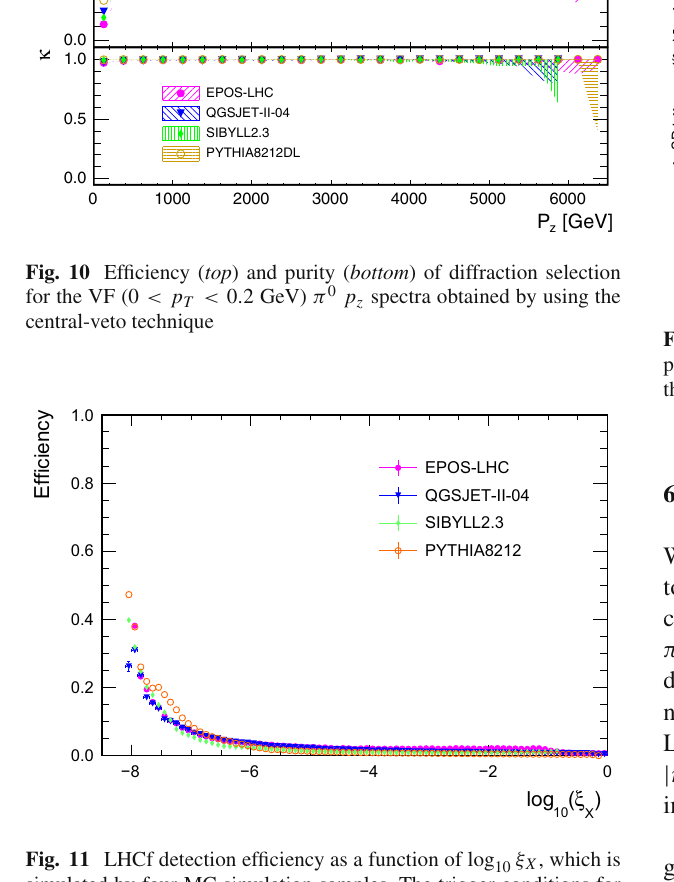
Fig. 11 LHCf detection efficiency as a function of log 10 ξ X , which is simulated by four MC simulation samples. The trigger conditions for √ s = 13 TeV are E γ > 200 GeV and E h > 500 LHCf detectors at GeV. Only the SD ( pp → pX ) component is used for this calculation